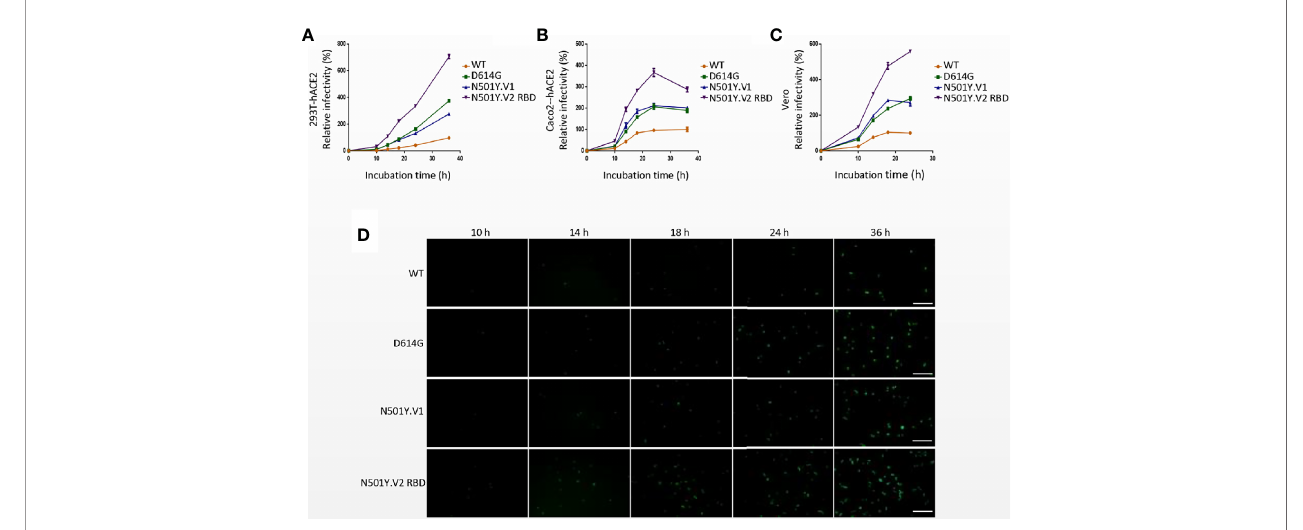
FIGURE 3 | Infection ef fi ciency of SARS-CoV-2 variants N501Y.V1 and N501Y.V2 RBD in target cells at different time points. (A – C) Infectivity analysis of SARS- CoV-2 WT, D614G, N501Y.V1 and N501Y.V2 RBD entry into 293T-hACE2 (A) , Caco2-hACE2 (B) , and Vero (C) cells at 10 h, 14 h, 18 h, 24 h, and 36 h. Transduction ef fi ciency was analyzed by luciferase activity in cell lysates. The infection ef fi ciency of viruses was calculated by dividing the RLU values at each time point by the average SARS-CoV-2 WT RLU values at 36h. Experiments were done in 4 replicates and repeated at least twice. One representative is shown with error bars indicating SEM. (D) Representative images of SARS-Cov-2 WT, D614G, N501Y.V1 and N501Y.V2 RBD entry into 293T-hACE2 cells at indicated time points. The scale bar indicates 200